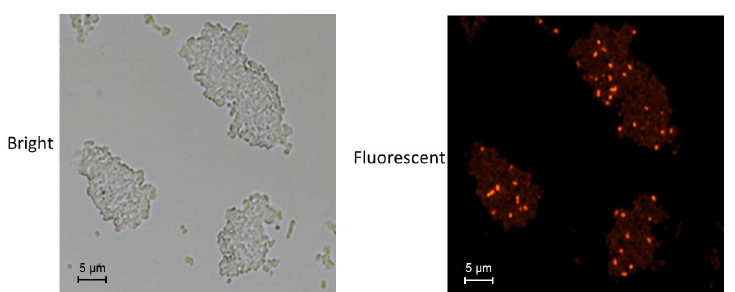
Fig 7. Fluorescence microscopic analysis of Top10/pPpbr-RFP-lacZ α bacterial lawn picked from the LB agar plate treated with 20 μ M Pb(II) plus 0.1 mM IPTG. Bacterial cells were visualized on slides using a Nikon Eclipse Ni fluorescence microscope (X400